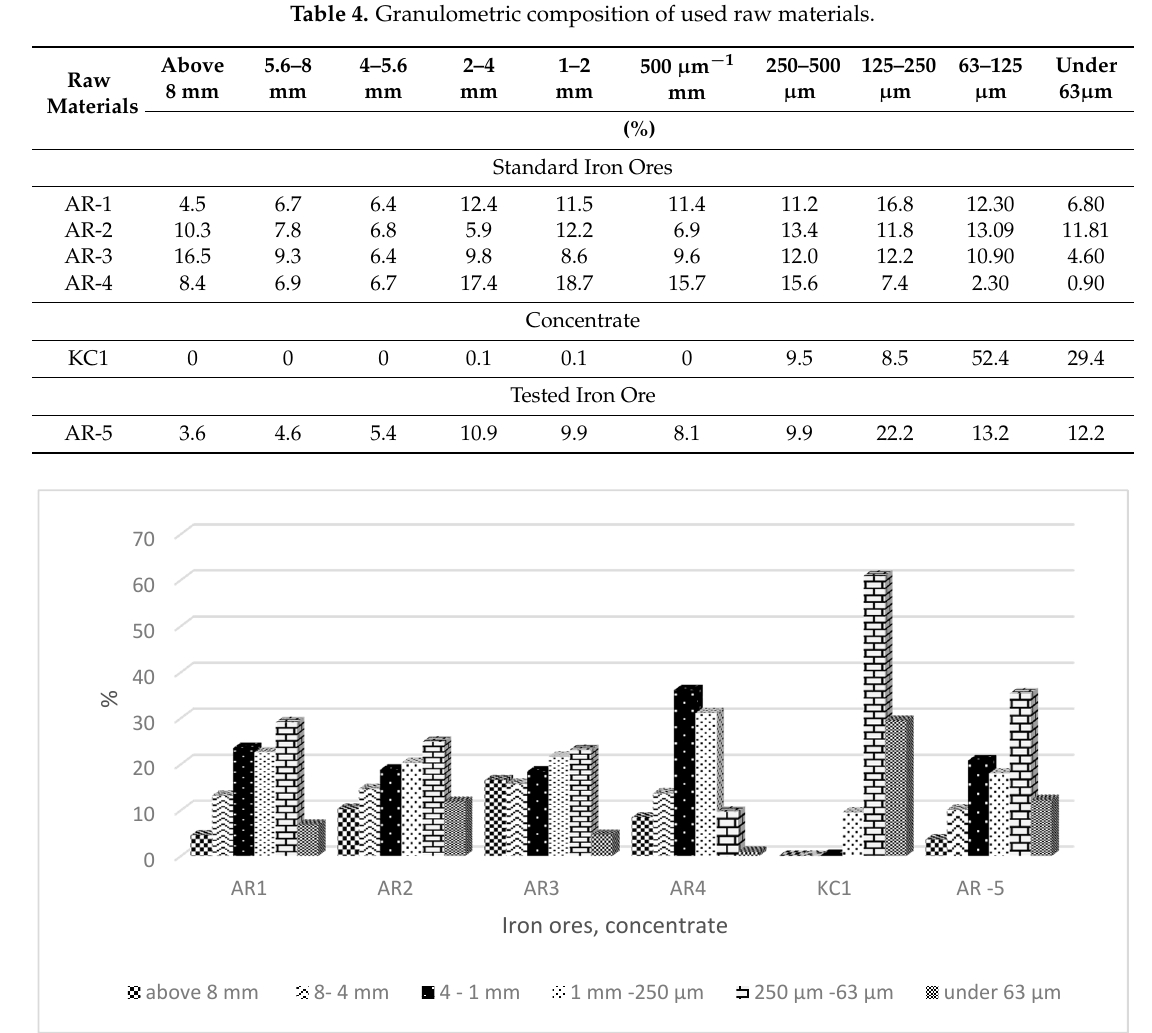
Table 3. Chemical composition of the tested iron ore used in the experiment.